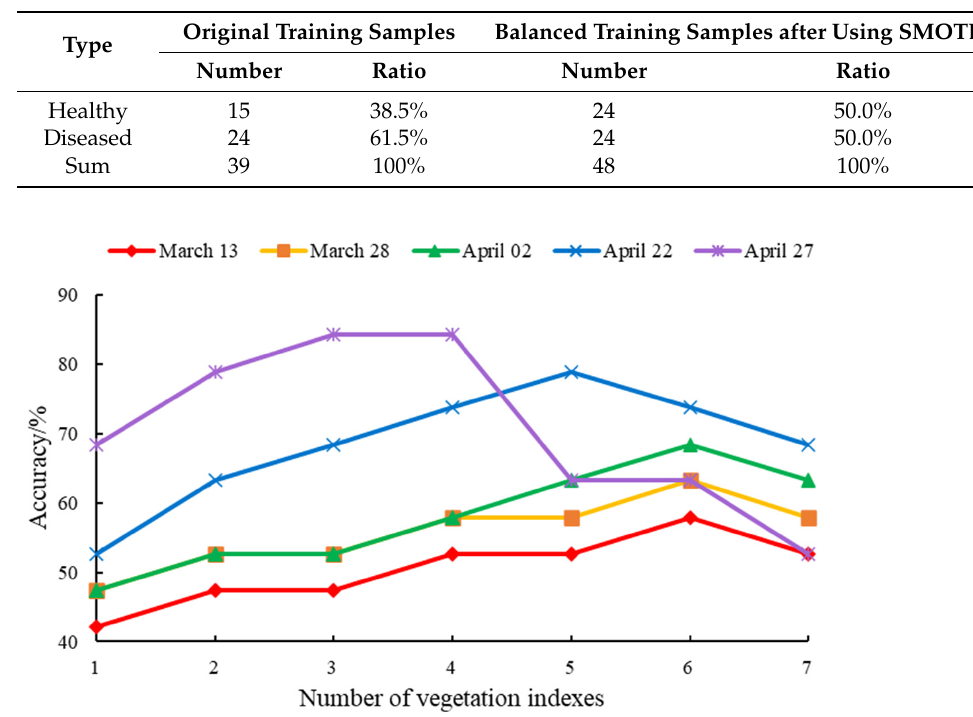
Figure 4. The weight coefficients of the vegetation indices and stripe rust at five dates, calculated by the relief algorithm. The high weight coefficient indicates the strong correlation between the vegetation indices and stripe rust. Table 4. The sample distribution of the original training samples and balanced training samples calculated by the synthetic minority oversampling technique (SMOTE) algorithm. The training samples were obtained from 58 field survey samples using a 7:3 ratio.